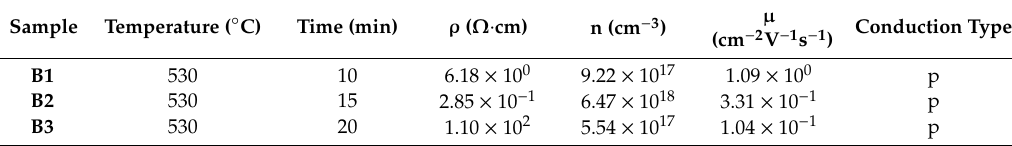
Figure 11. The plot of ( α h υ ) 2 vs. h υ for the absorption spectra. Inset: Bandgap variation as a function of the selenization time. Table 6. Electrical properties of the CMZTSSe films annealed for different times from 10 to 20 min.